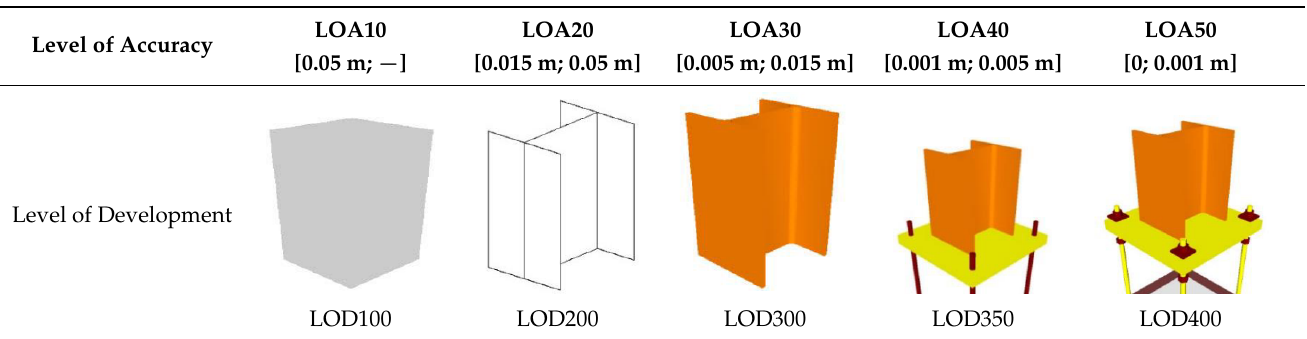
Table 1. Overview of the Level of Accuracy and Level of Development specification used in Scan-to- BIM methods and their different categories.